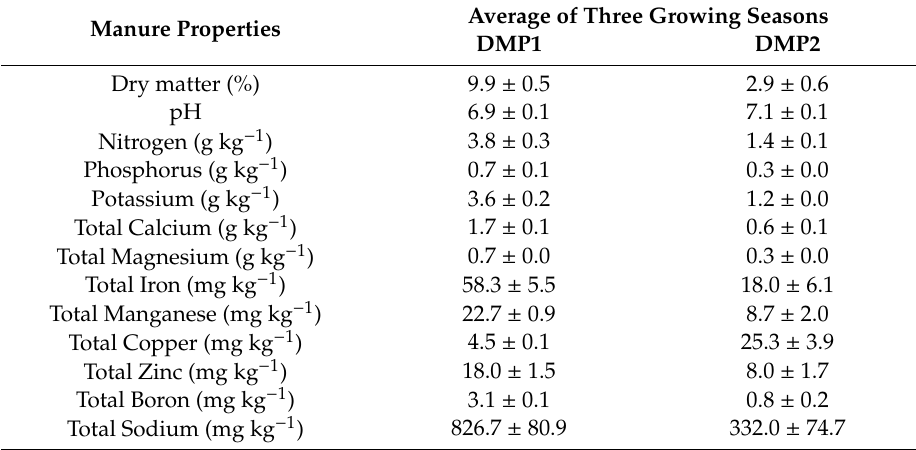
Table 4. Dairy manure analyses report of both sources used in this experiment. Values are means ± standard error for three years